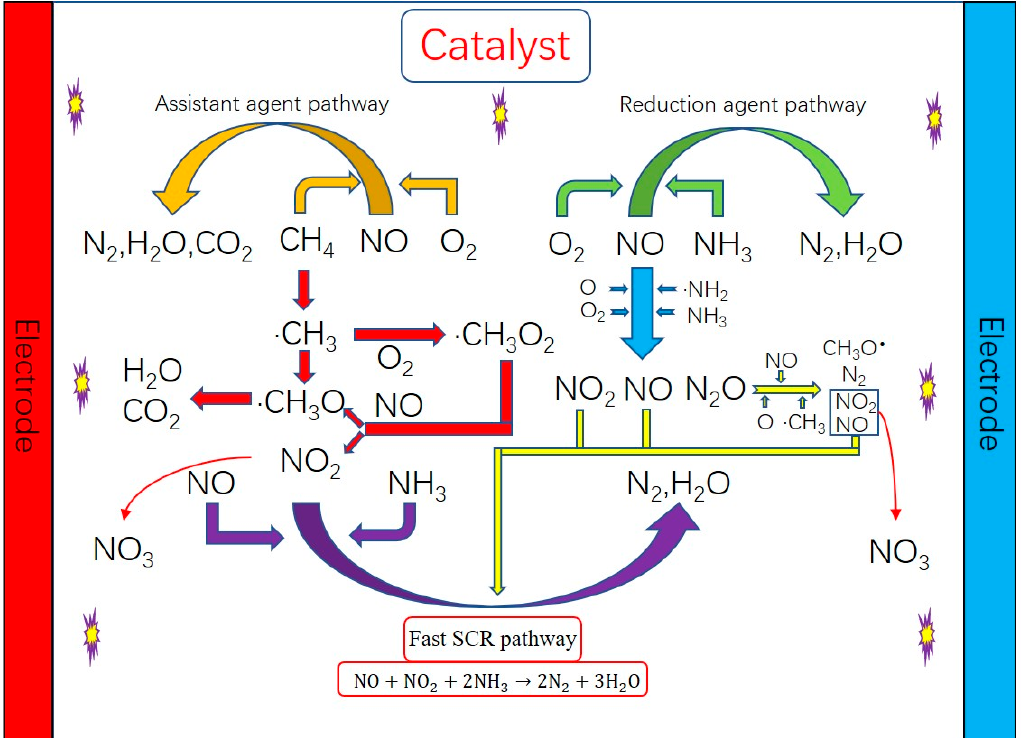
Figure 8. Schematic diagram of the main chemical reaction mechanism for the DBD–NH 3 –SCR using CH 4 as an assistant agent.